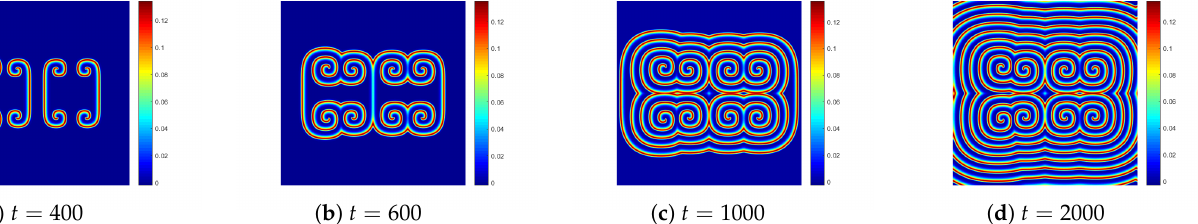
Figure 9. The stable spatio-temporal waves of v at α = 1.7 and different times for Experiment 2.